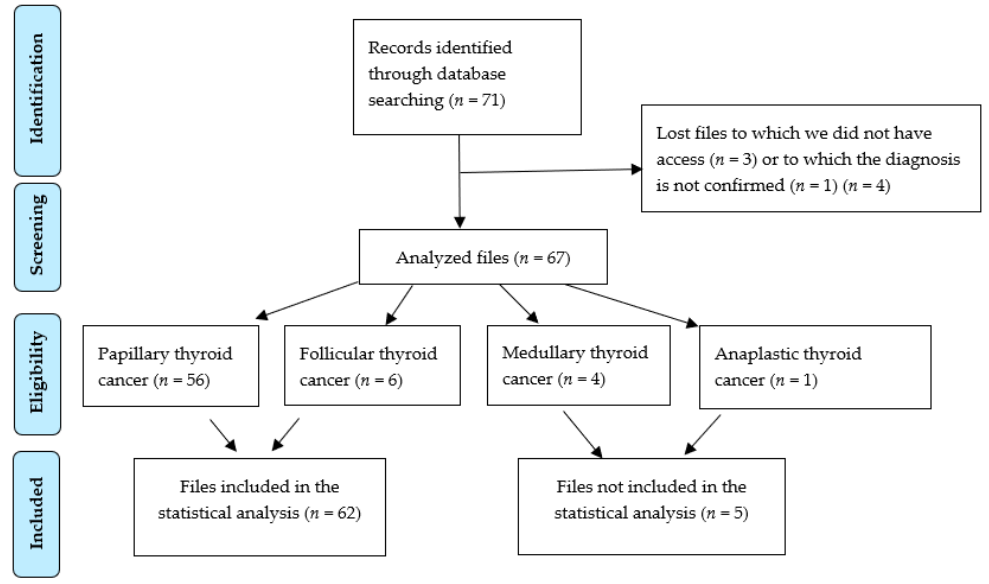
Figure 2. Patient selection criteria.